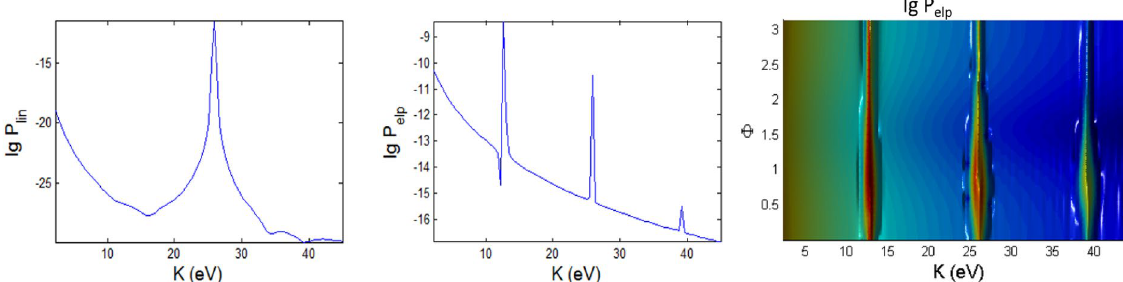
Figure 5. Same as Fig. 3 (versus angle Φ with t p = 100 fs) but for case